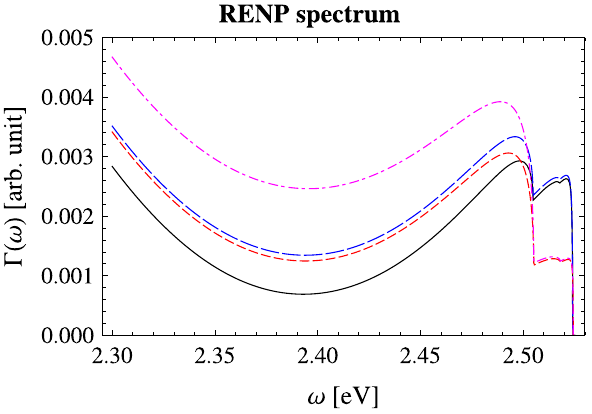
Fig. 2 ComparisonofDiracandMajoranaspectrafortheinverted(IO) and normal ordering (NO) cases with a parallel initial phase memory of r = 0 . 9: NO Dirac rate in solid black, NO Majorana in long-dashed blue, IO Dirac in short-dashed red, and IO Majorana in dash-dotted magenta for the smallest mass of 10 meV and assuming vanishing CP violating phases. Absolute rate value is obtained by multiplying 10 − 6 s − 1 for n = 10 2 cm − 3 , V = 10 2 cm 3 ,η = 1